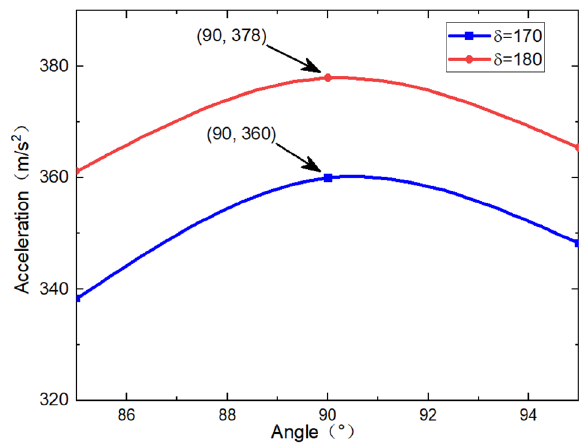
Fig. 12 Acceleration at different angle of eccentric mass